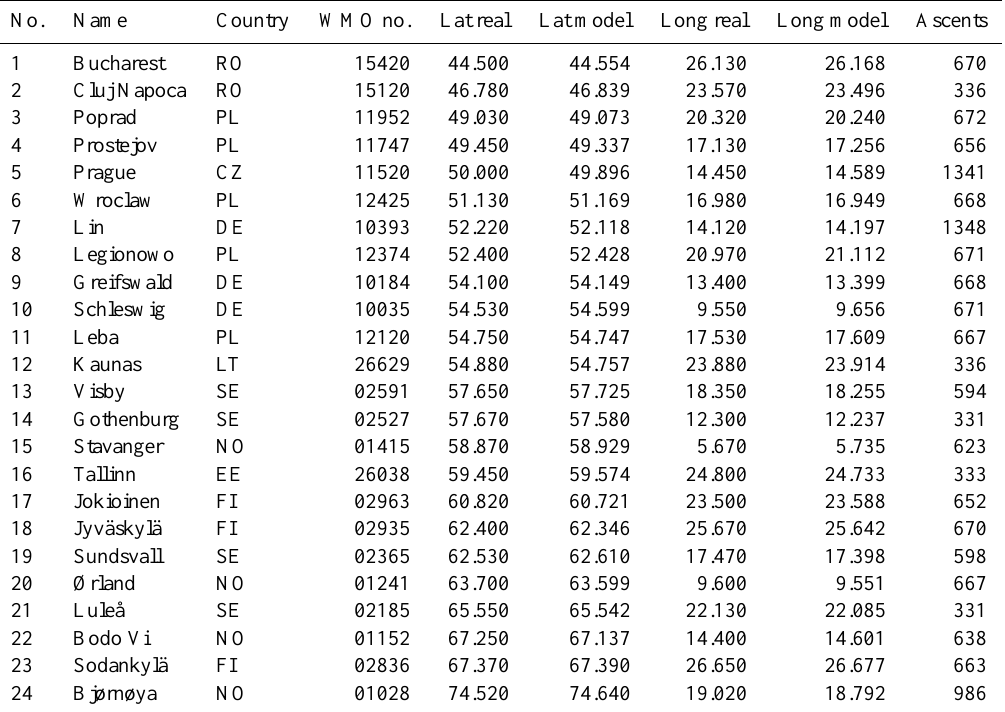
Table B3. Same as Table B2 but for those stations outside of Russia used to compare to those in Russia.